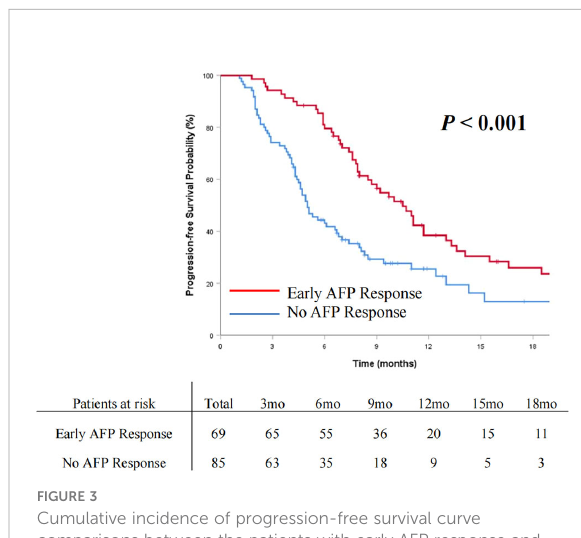
FIGURE 2 Cumulative incidence of overall survival curve comparisons between the patients with early AFP response and no AFP response in the entire cohort.